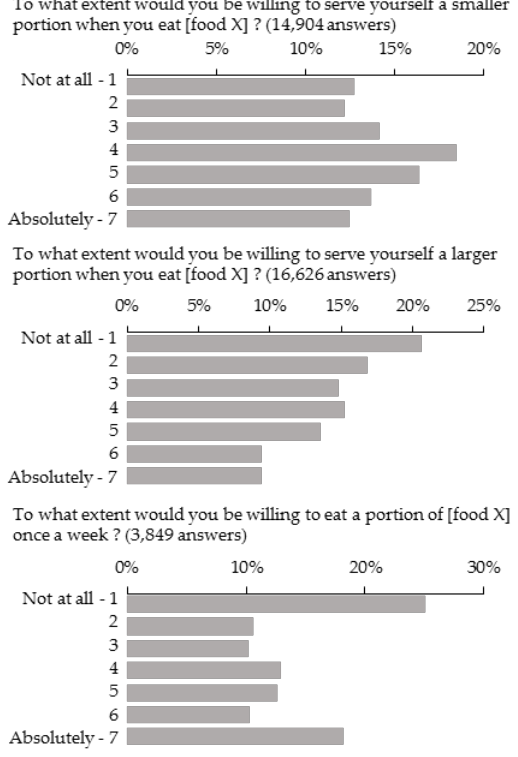
Figure 2. Distribution of scores for each type of modification, all foods combined, in the questionnaire sample (2018, n = 2055).